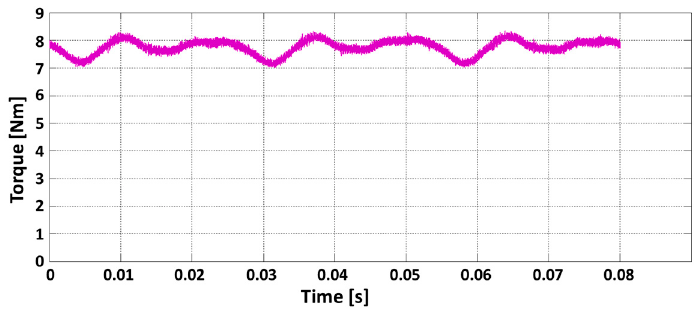
Figure 20. Input currents for the prototype machine.